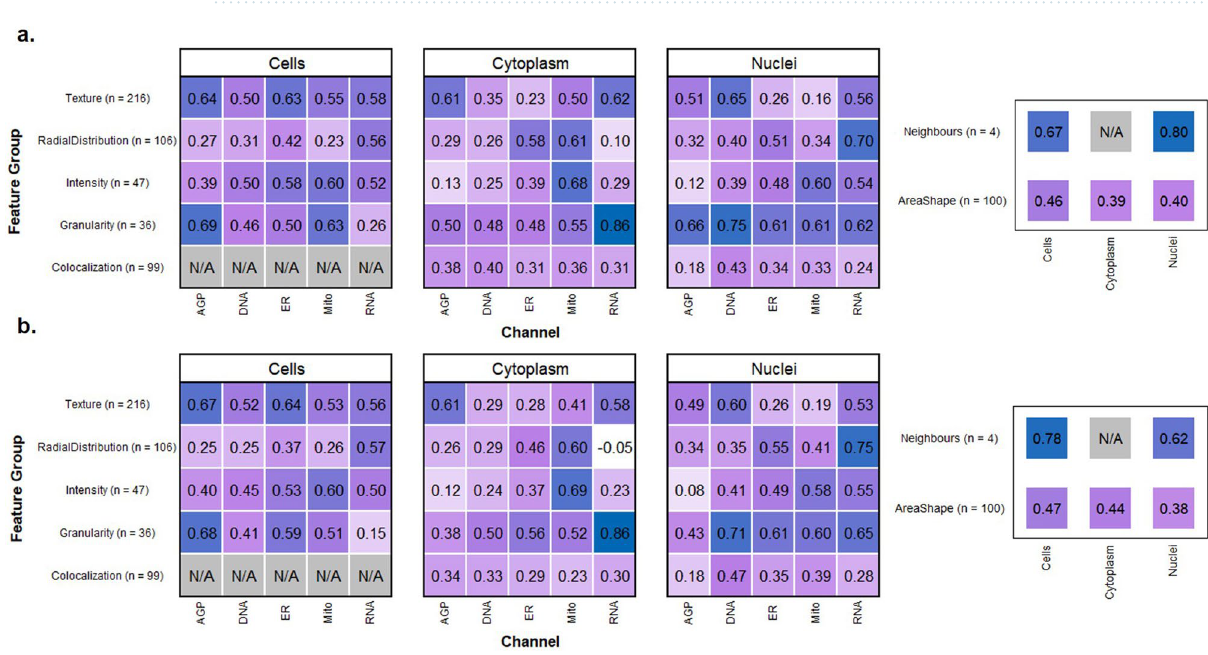
Figure 5. A systematic breakdown of correlation between morphological profiles. The features selected from the CellProfiler pipeline are presented as correlation heatmaps in ( a ) (U-Net) and ( b ) (cWGAN-GP). The correlations for each model are with the features extracted from the ground truth Cell Painting images and are aggregated by channel and feature group for cell, cytoplasm, and nuclei objects. The number of features for each feature group is also presented. U-Net mean = 0.43, cWGAN-GP mean =